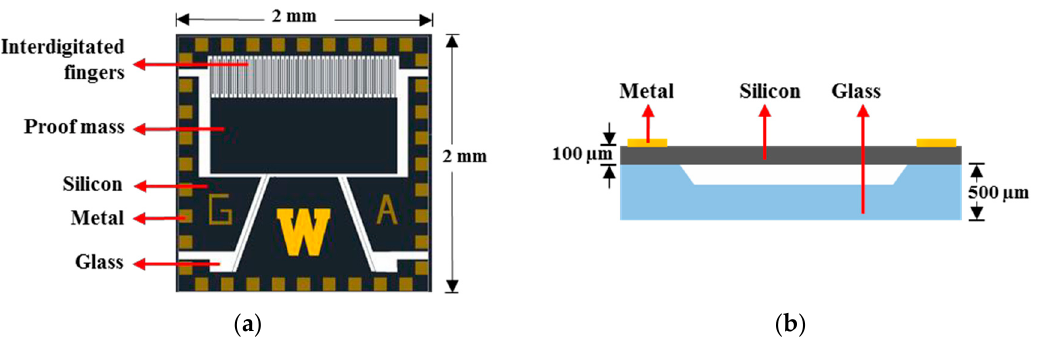
Figure 1. Schematic of the pulsometer: ( a ) top view and ( b ) side